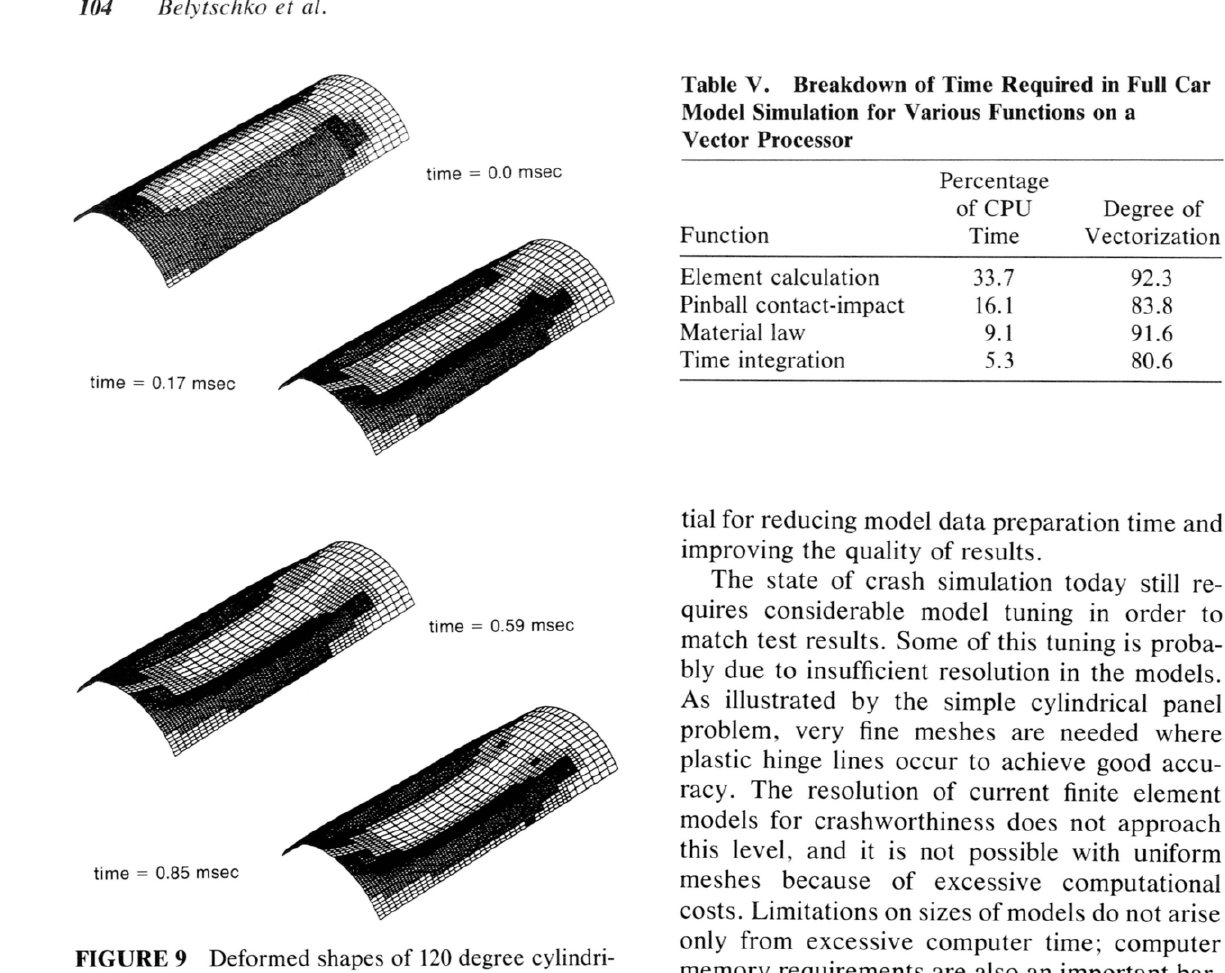
FIGURE 9 Deformed shapes of 120 degree cylindri cal panel.